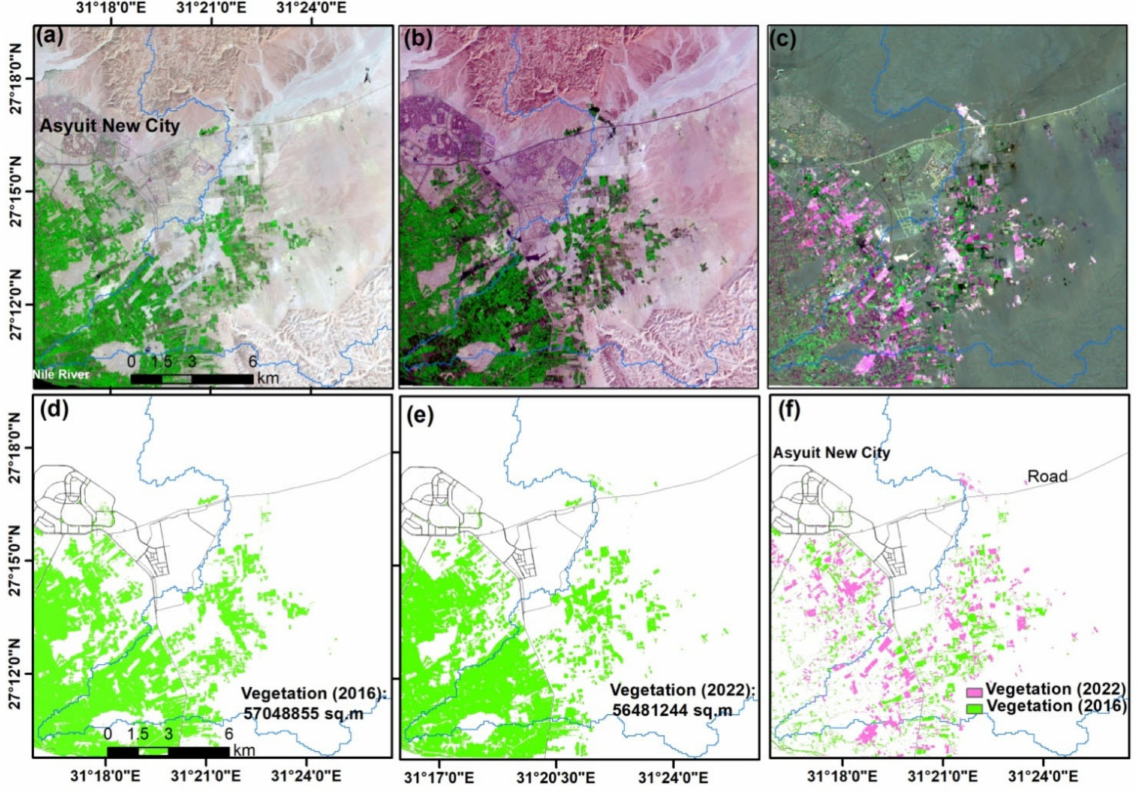
Figure 11. ( a , b ) Sentinel-2 data from the downstream area; ( c ) difference map between two scenes of Sentinel-2 14 March 2022 and 20 March 2016; ( d ) vegetated area in 2016; ( e ) vegetated area in 2022; ( f ) differences in vegetation between 2016 and